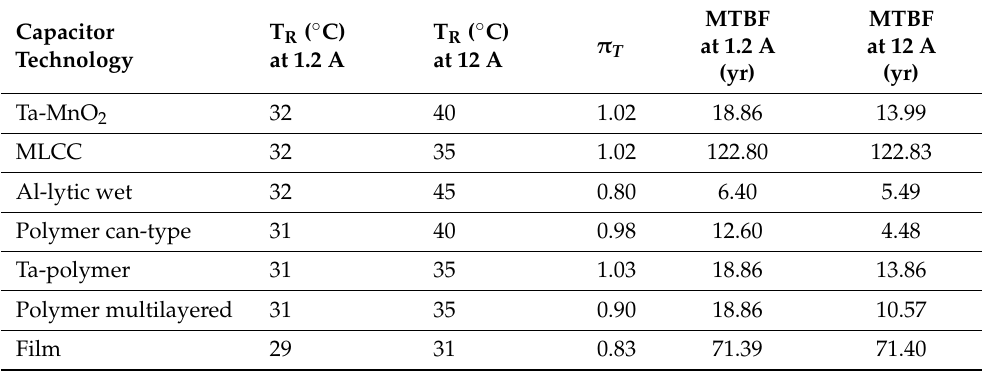
Table 6. Indices of reliability yield at load current of 1.2 A and 12